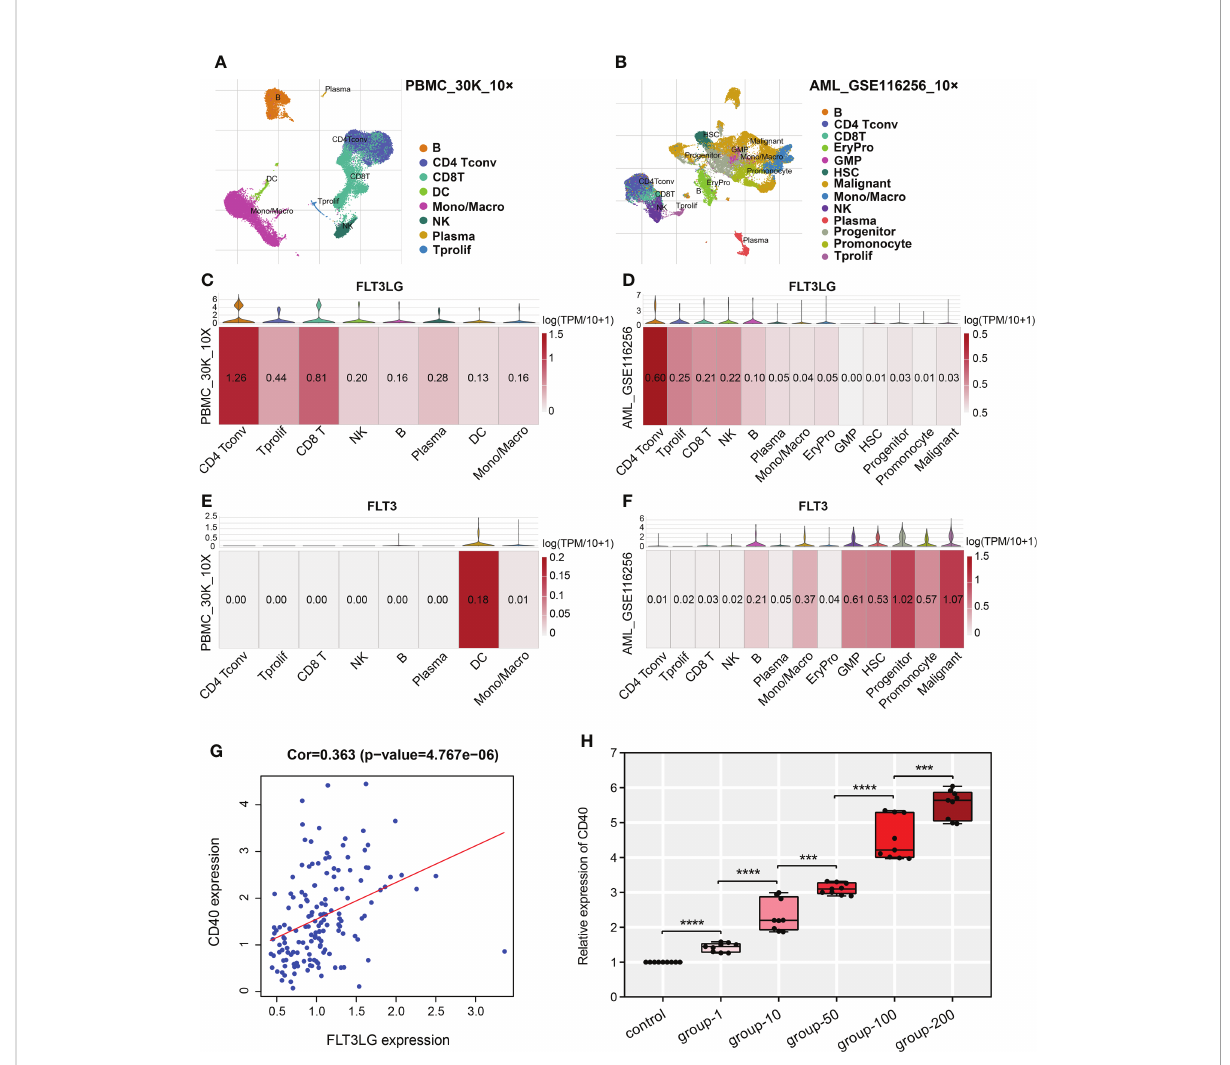
FIGURE 6 Single-cell transcriptome analysis revealed detailed gene location in various cell types. (A, B) UMAP cluster after cluster analysis of peripheral blood mononuclear cells (PBMC) and acute myelocytic leukemia (AML). (C, E) Violin plot and heatmap of FLT3LG and FLT3 expression in the PBMC_30K_10× dataset. (D, F) The transcription level of FLT3LG and FLT3 in cell types of the AML_GSE116256 dataset. (G) FLT3LG expression was positively correlated with CD40 expression in TCGA data. (H) CD40 expression was signi fi cantly elevated when Flt3lg cytokine activation in dendritic cells. *** p < 0.001; **** p <